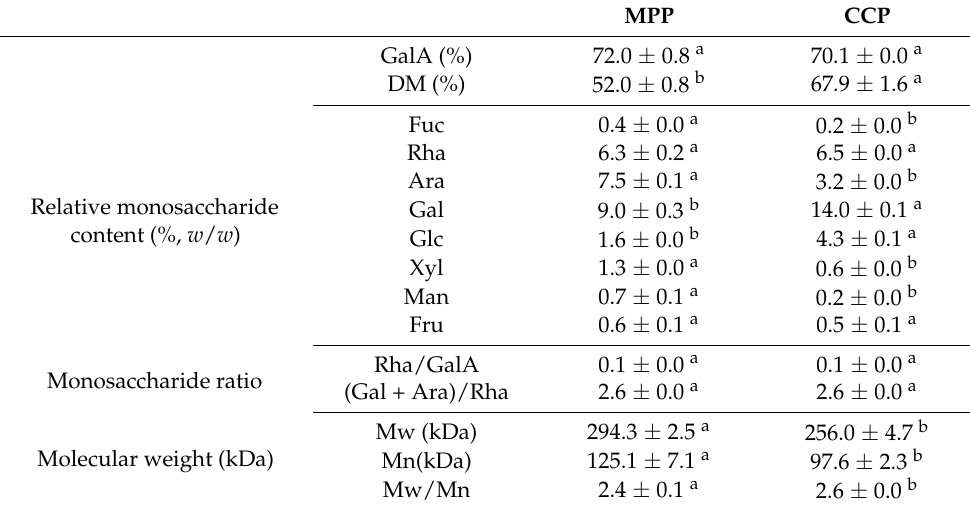
Table 3. The monosaccharide composition, DM, and molecular weight of MPP and